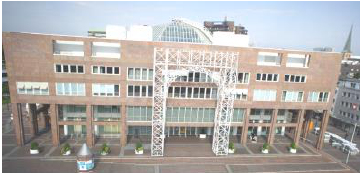
Figure 4. Aerial oblique photo of City Hall